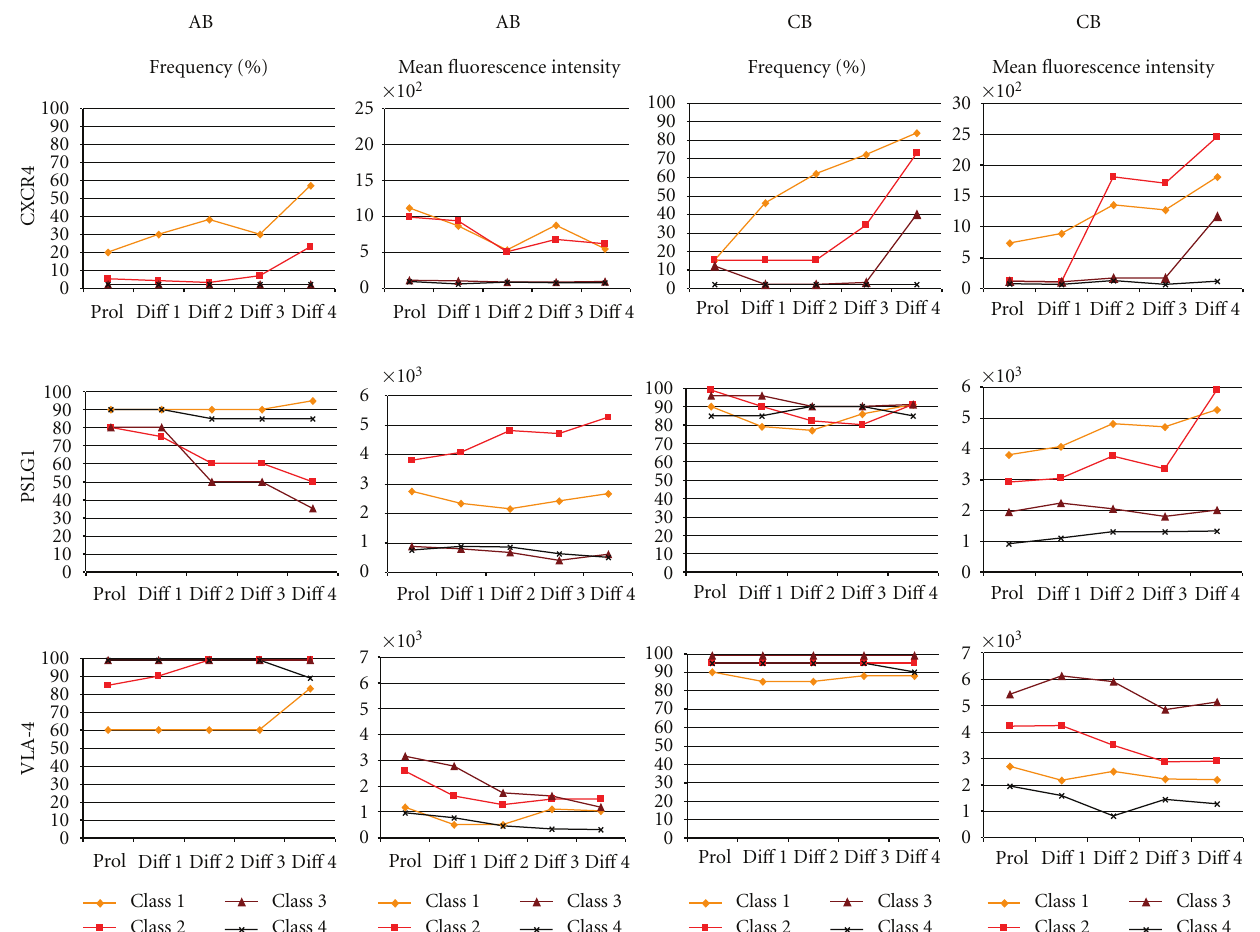
Figure 3: Time course of the frequency and MFI of CXCR4, PSL1, and VLA4 expression during in vitro maturation of EBs expanded from adult and cord blood, as indicated. Values observed with EBs at di ff erent stages of maturation are color coded: Class 1 (gate R1): light orange, Class 2 (gate R2): red, Class 3 (gate R3): brown, and Class 4 (gate R4): black (see also Supplemental Figure 1). The results correspond to the flow charts presented in Figure